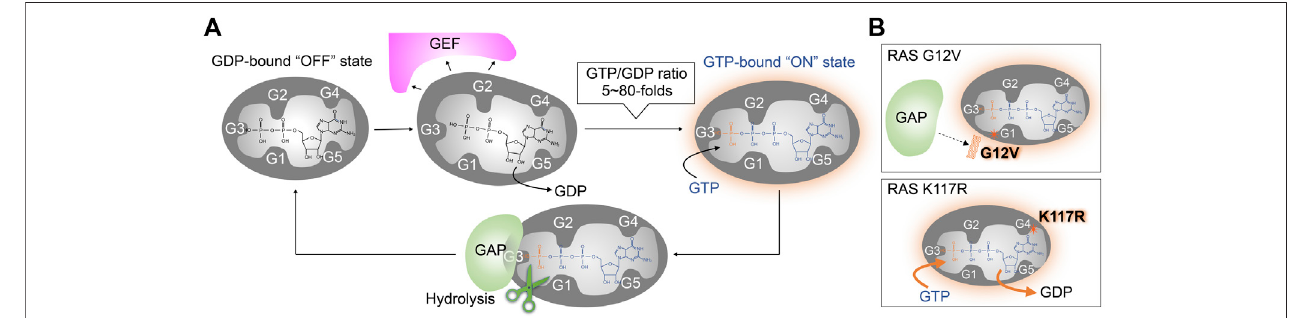
FIGURE2 | Wild type and oncogenic RASregulation byGEFs and GAPs. (A) The RASnucleotide cyclingregulated by GEF and GAP. GEFs bind to RAS, inducing conformationchangesthatreducetheRASaf fi nityforguaninenucleotideligands.ThisleadstothedissociationofGDPandtheformationofthenucleotide-freeapo-form ofRASfromtheGDP-bound “ OFF ” state.StochasticGTPloadingtotheapo-formofRASfacilitatingtheGTP-bound “ ON ” state,duetothehigherGTP/GDPratiosinthe cell. GAPs bind to the GTP-bound RAS and increases its intrinsic GTPase activity for GTP hydrolysis. (B) Activation mechanism of oncogenic RAS mutant. Upper: TheRASG12VoncogenicmutantimpairsbothintrinsicGTPaseactivityandGAP-dependentGTPhydrolysis.Lower:theRASK117RmutantmaintainsintrinsicGTPase activity and GAP-dependent GTP-hydrolysis, but decreases the nucleotide af fi nity, leading to an increased GTP/GDP